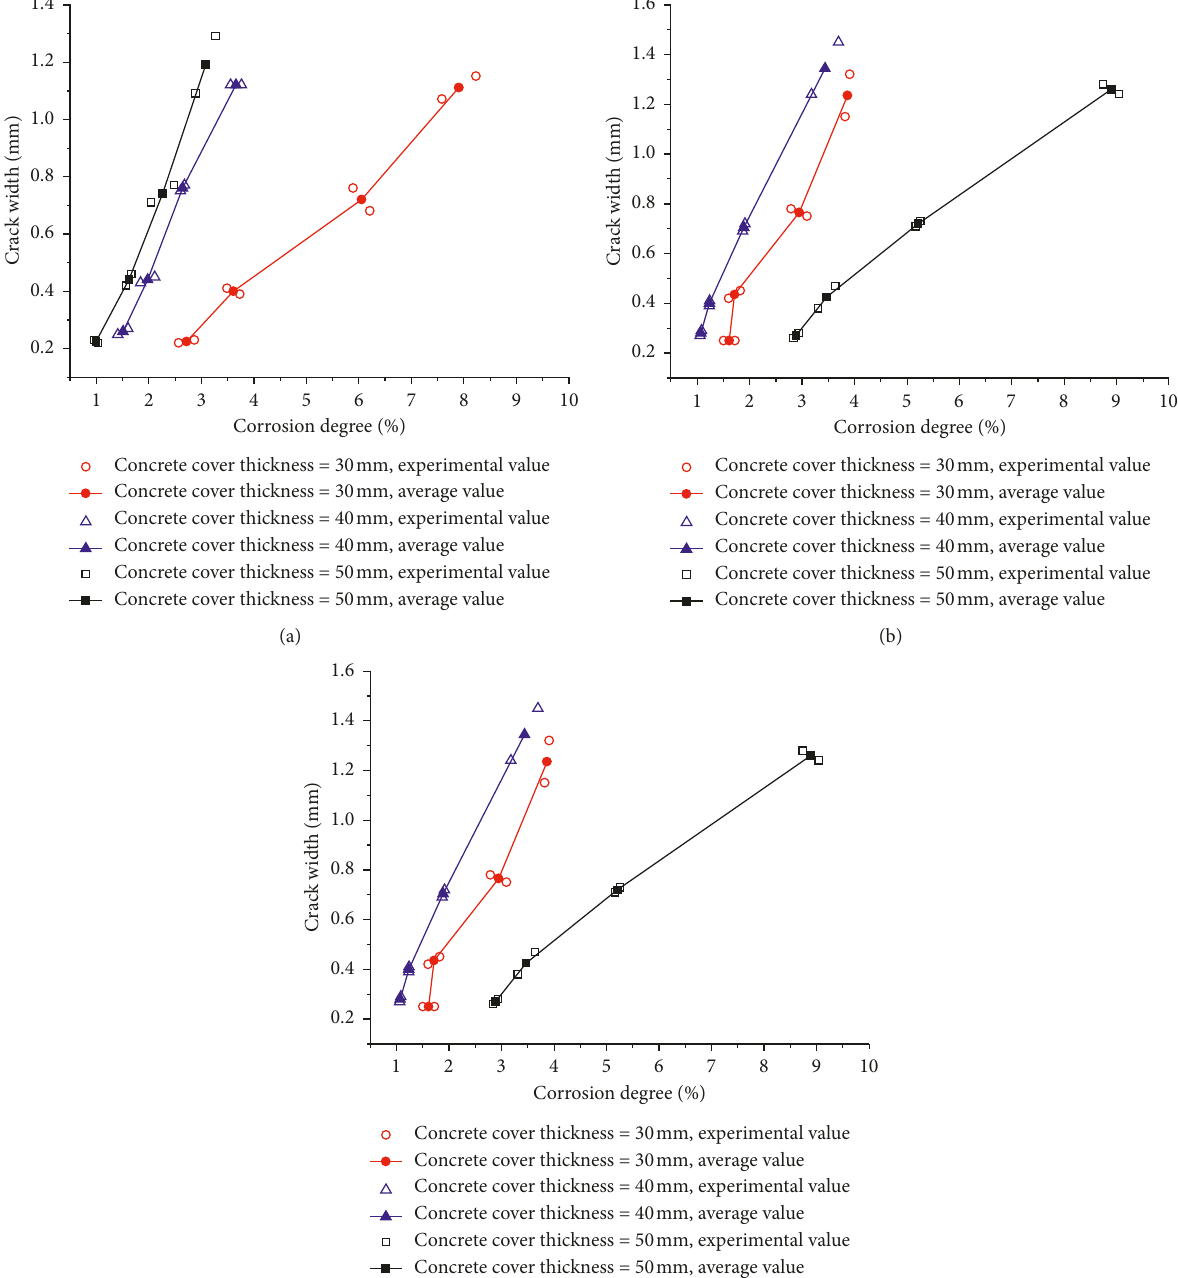
Figure 14: Effect of thickness of concrete cover on the relationship between cracking width and steel corrosion degree for different water- cement ratios: (a) W/C � 0 . 3; (b) W/C � 0 . 4; (c) W/C � 0 .